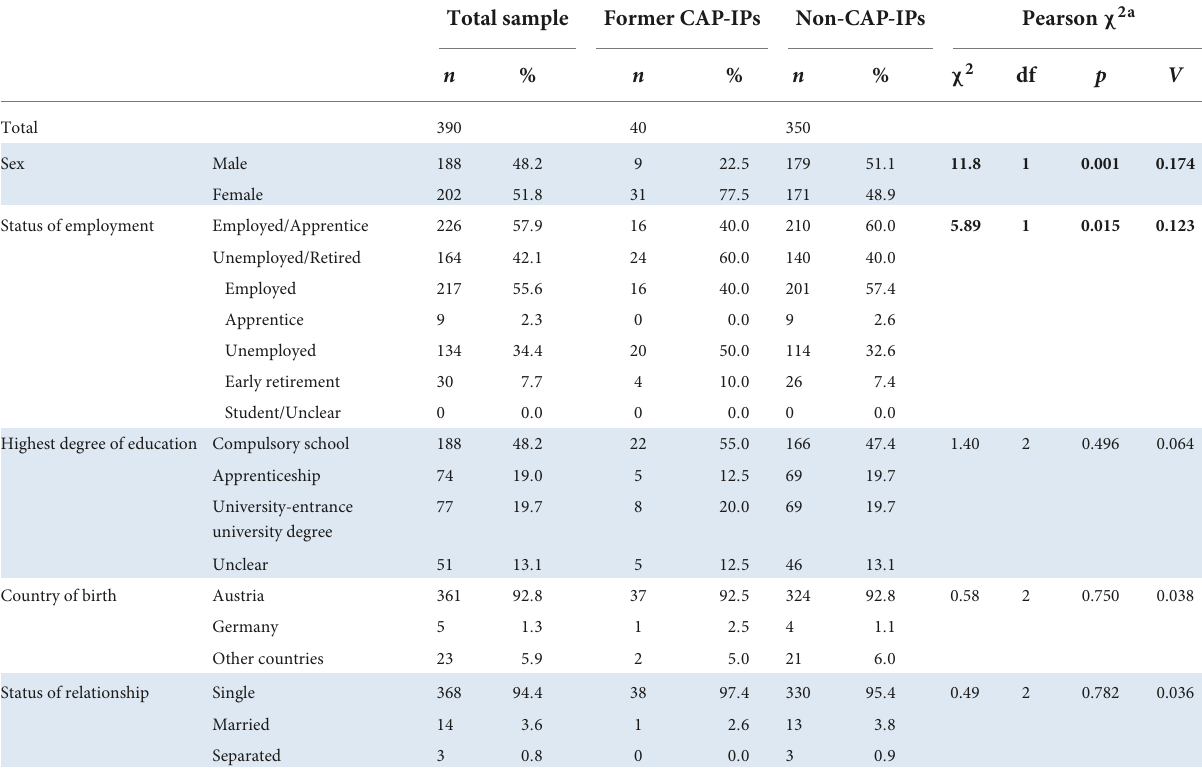
TABLE 1 Sociodemographic characteristics of the total sample of young adult inpatients ( n , %) and specifically listed ( n , %) and compared (Pearson χ 2 ) those with a former child and adolescent psychiatric inpatient treatment (former CAP-IPs) and those without a former CAP admission